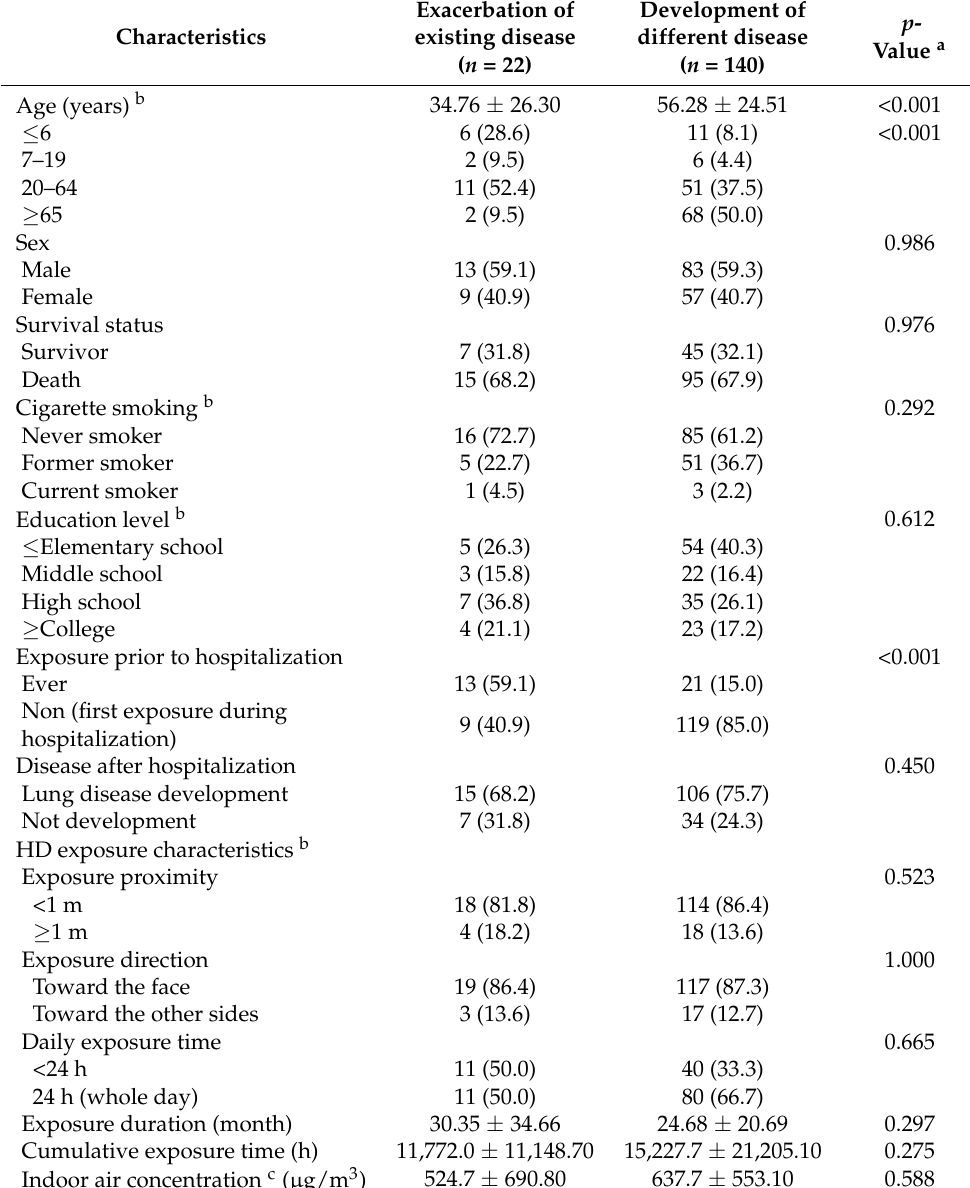
Table 2. Characteristics of participants by disease status change during hospitalization.